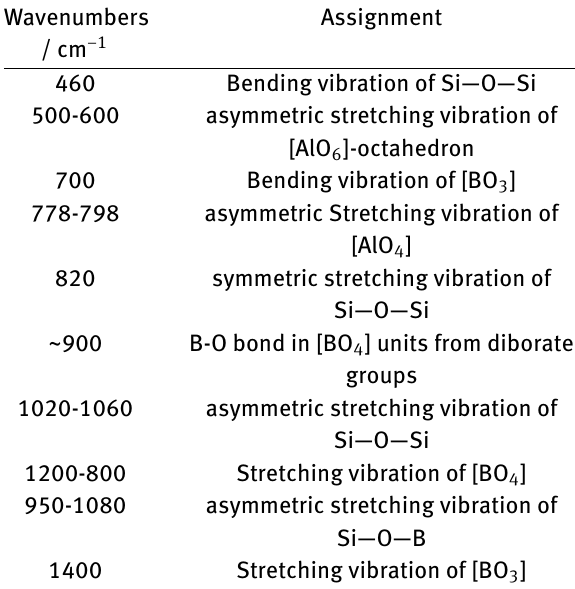
Table 6: Main Vibration Types and Their Absorption Bands Wavenumbers